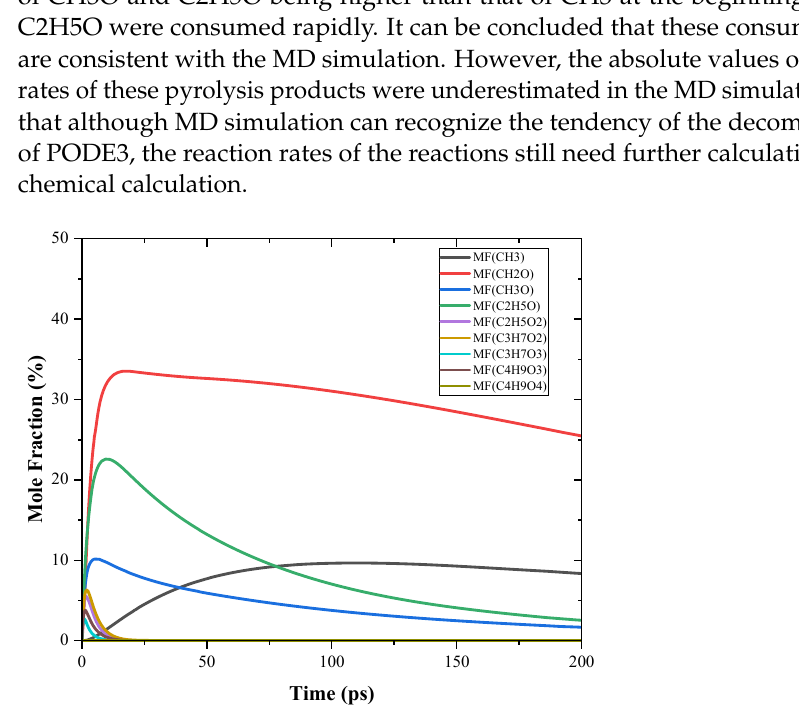
Figure 11. The mole fractions of the initial pyrolysis products of PODE3 by chemical kinetic study at 3000 K. MF stands for Mole Fraction in the legend.